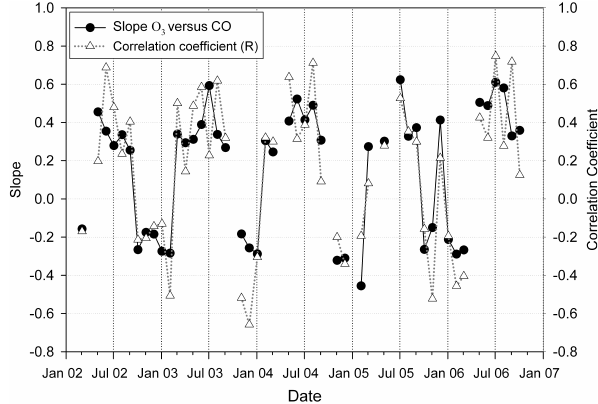
Fig. 9. Time series of slope and coefficient of determination for hourly O 3 versus CO relationships for each month based on the reduced major axis regression. The slopes are not shown when the p-value of the regression is less than 0.05.